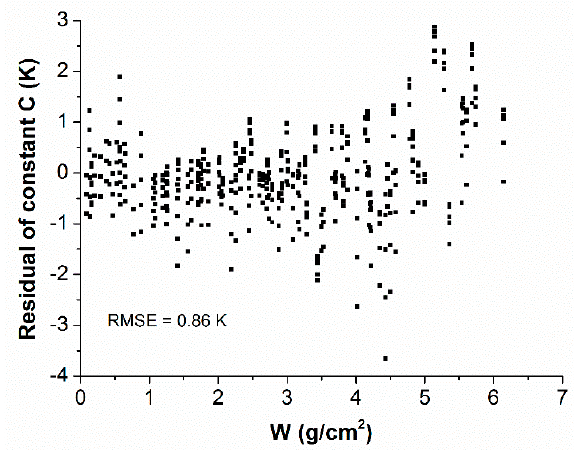
Figure 11. The residual of constant C calculated using Equation (3) for W < 1 g/cm 2 and using Equation (8) for W > 1 g/cm 2 .